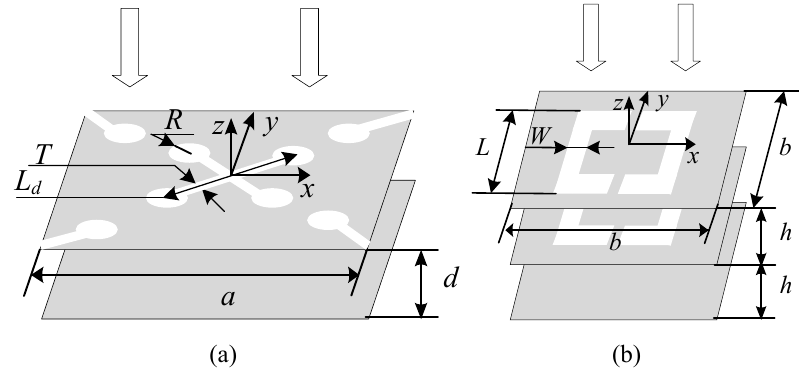
Fig. 1. Unit cell: (a) with single-layer crossed dumbbell slots, a =8.85 mm, d =9 mm ; (b) with two-layer square-loop slots, b =12 mm, h =3 mm, L d =5.71 mm.